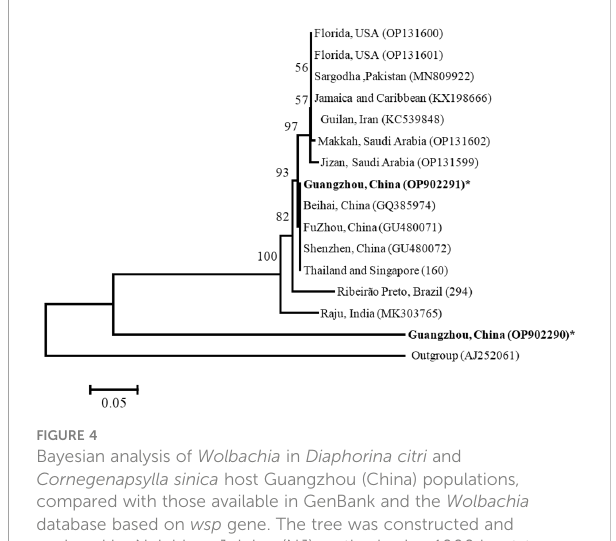
FIGURE 4 Bayesian analysis of Wolbachia in Diaphorina citri and Cornegenapsylla sinica host Guangzhou (China) populations, compared with those available in GenBank and the Wolbachia